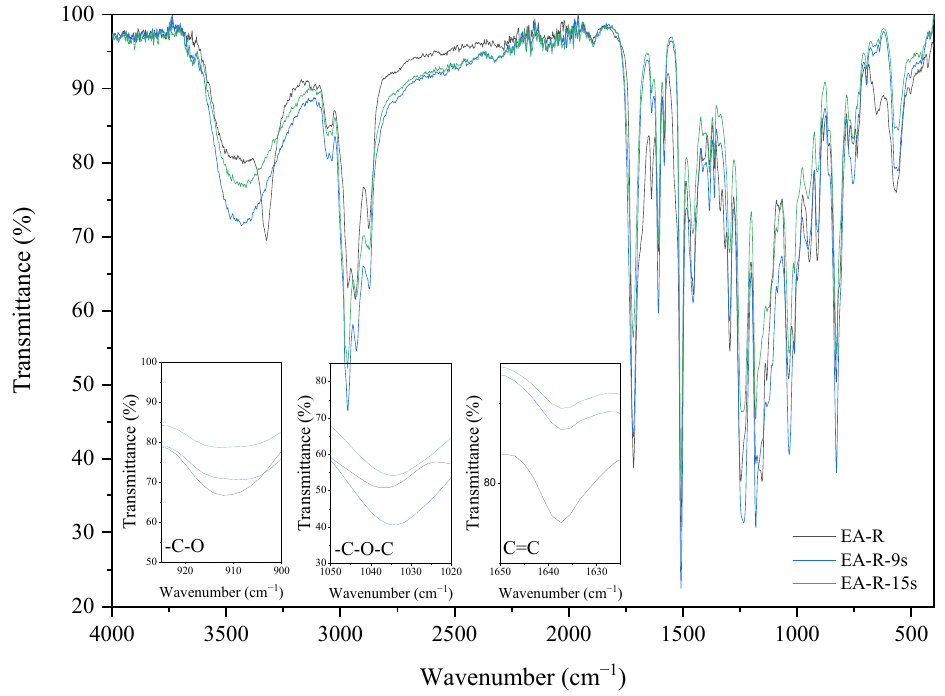
Molecules 2021 , 26 , 7663 Figure 7. The FT-IR spectra of the EA-R sample before and after 9 and 15 s of UV irradiation (composition of the photoreactive formulations: 96 wt% of EA prepolymer, 4 wt% of radical PI).